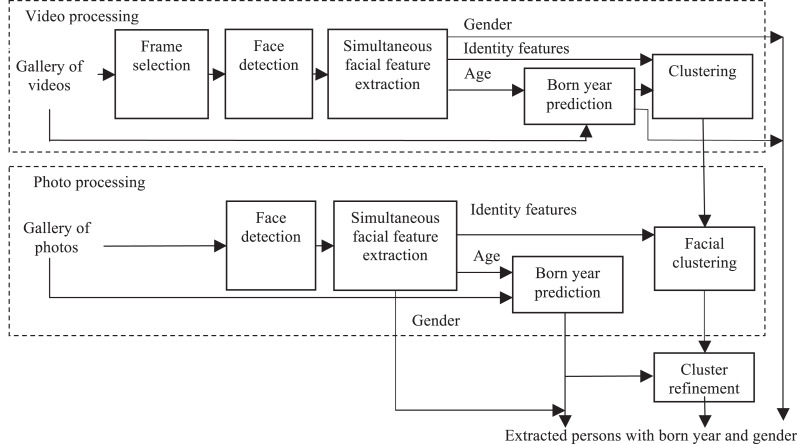
Proposed pipeline.